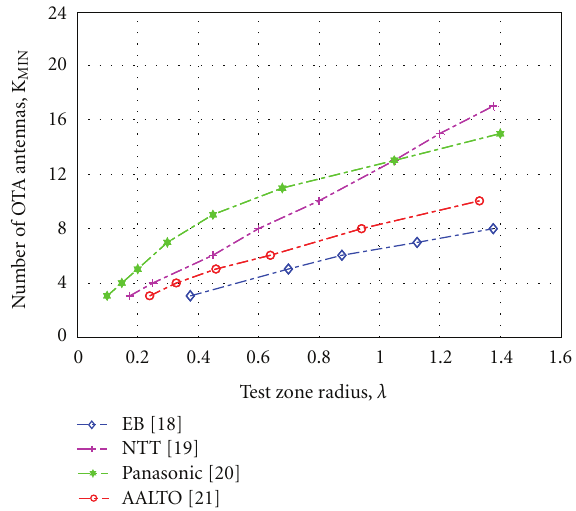
Figure 3: The number of probes as a function of the test zone radius for the single cluster model with the Laplacian distributed PAS with the angular spread of 35 ◦ when the probes are placed in an optimum azimuth